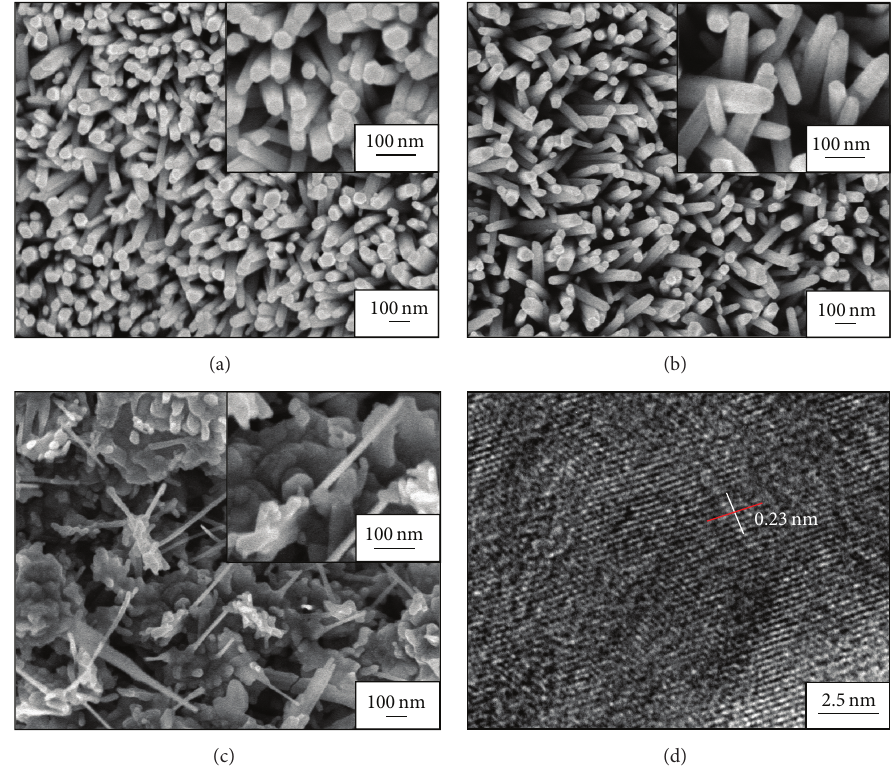
Figure 2: FESEM images: (a) 1V of electrochemical deposition applied potential; (b) 2 V of electrochemical deposition applied potential; (c) 3 V of electrochemical deposition applied potential. HRTEM image: (d) 1V of electrochemical deposition applied